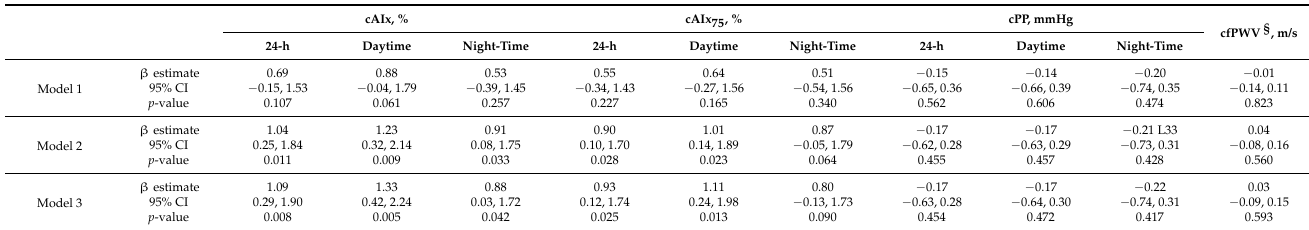
Table 5. Estimated effect ( β ) of an IQR increase in indoor VOC concentrations on measures of arterial stiffness.